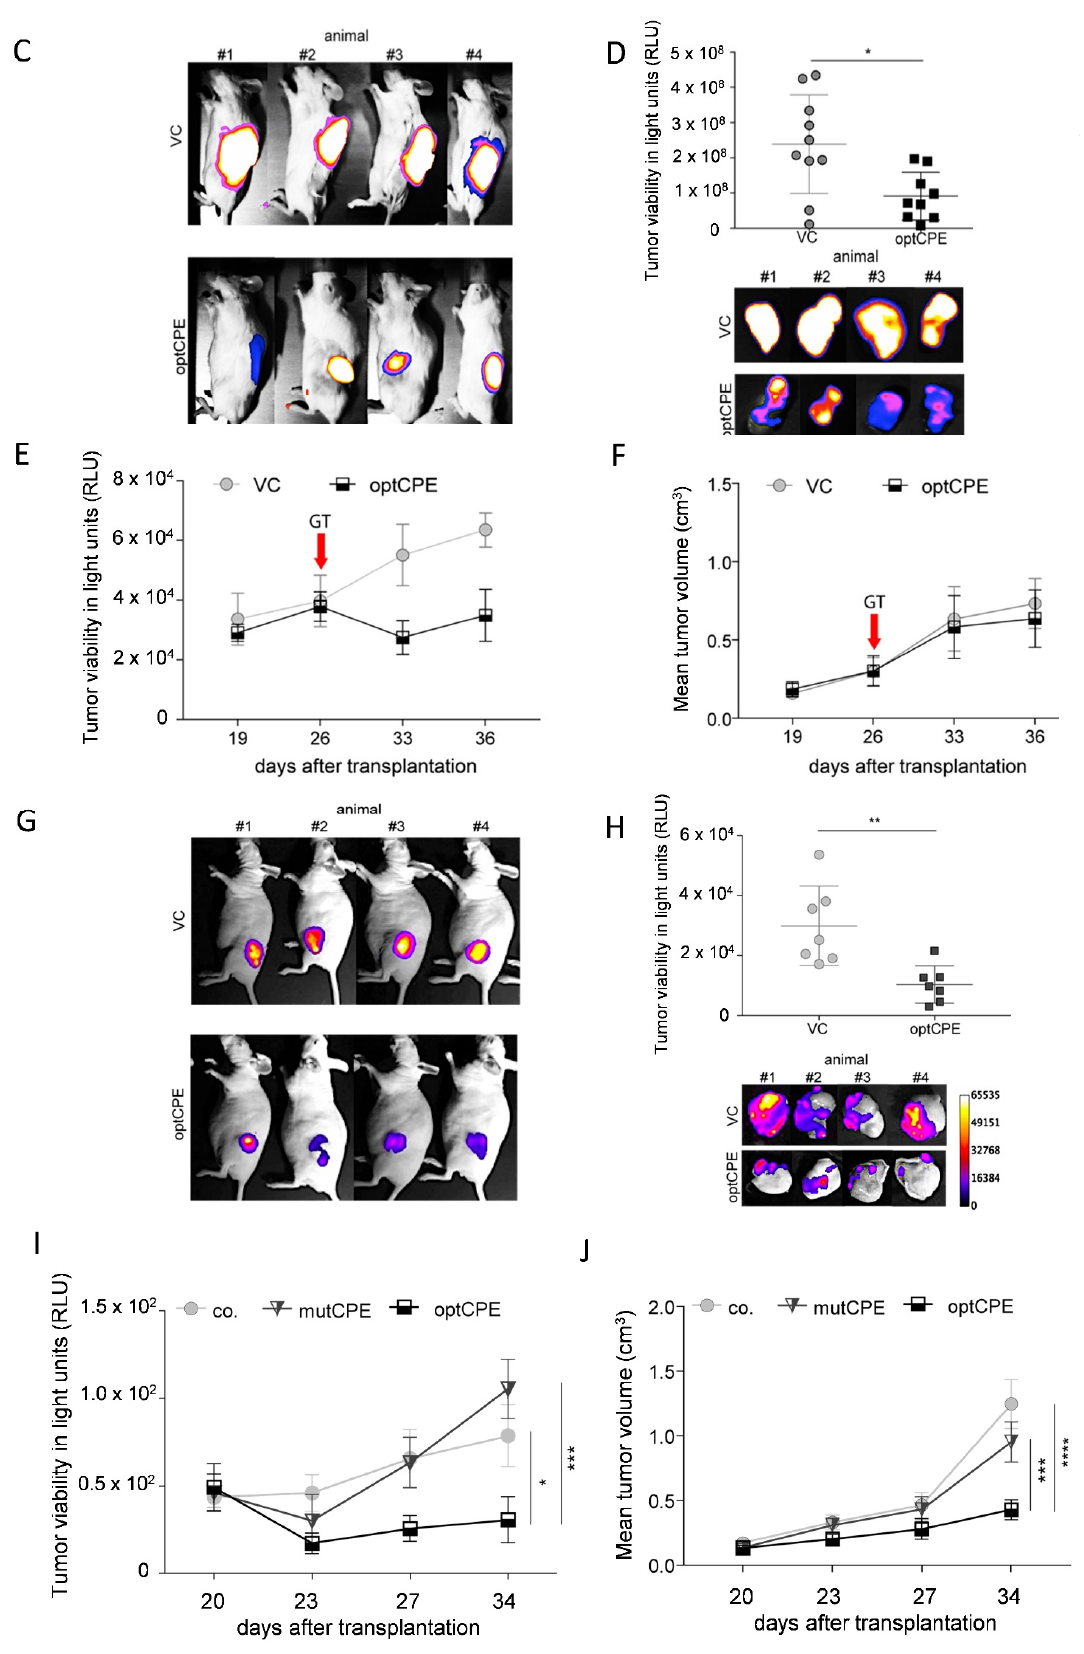
Figure 6. Cont Figure 6. Therapeutic efficacy of non-viral in vivo optCPE gene transfer. ( A ) 34 days after cell injection of optCPE gene transfer (GT) was performed. By this, significant inhibition of tumor viability (determined by bioluminescence; BL), and ( B ) tumor growth (measured via mean tumor volume) was observed in MIA PaCa-2/eGFP-Luc bearing mice compared to